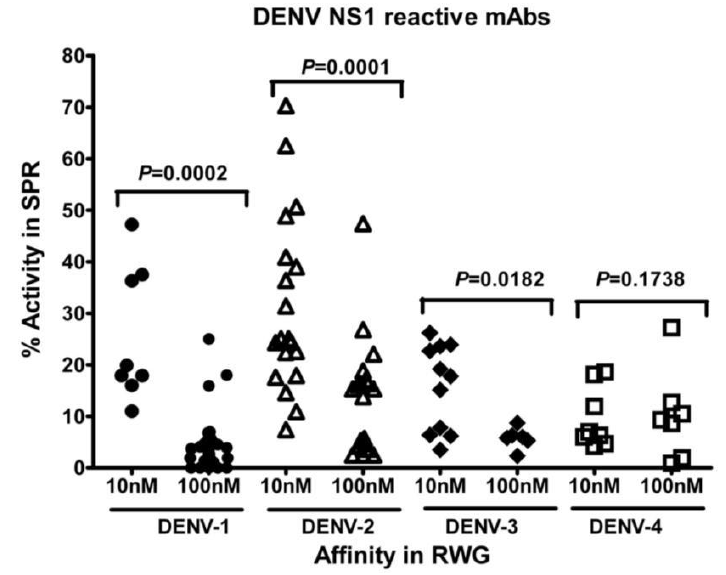
Figure 5. Comparison of SPR determined percent activity of mAbs between mAbs of different affinity subset, 10 nM and 100 nM in RWG. P value above the dots represents the statistical difference between both subsets of mAbs. In this study, except DENV-4 reactive mAbs, the percent activities of the other three mAb serotypes were significantly higher in mAbs with affinity of 10 nM (RWG) than that of with affinity of 100 nM (RWG) using Mann-Whitney